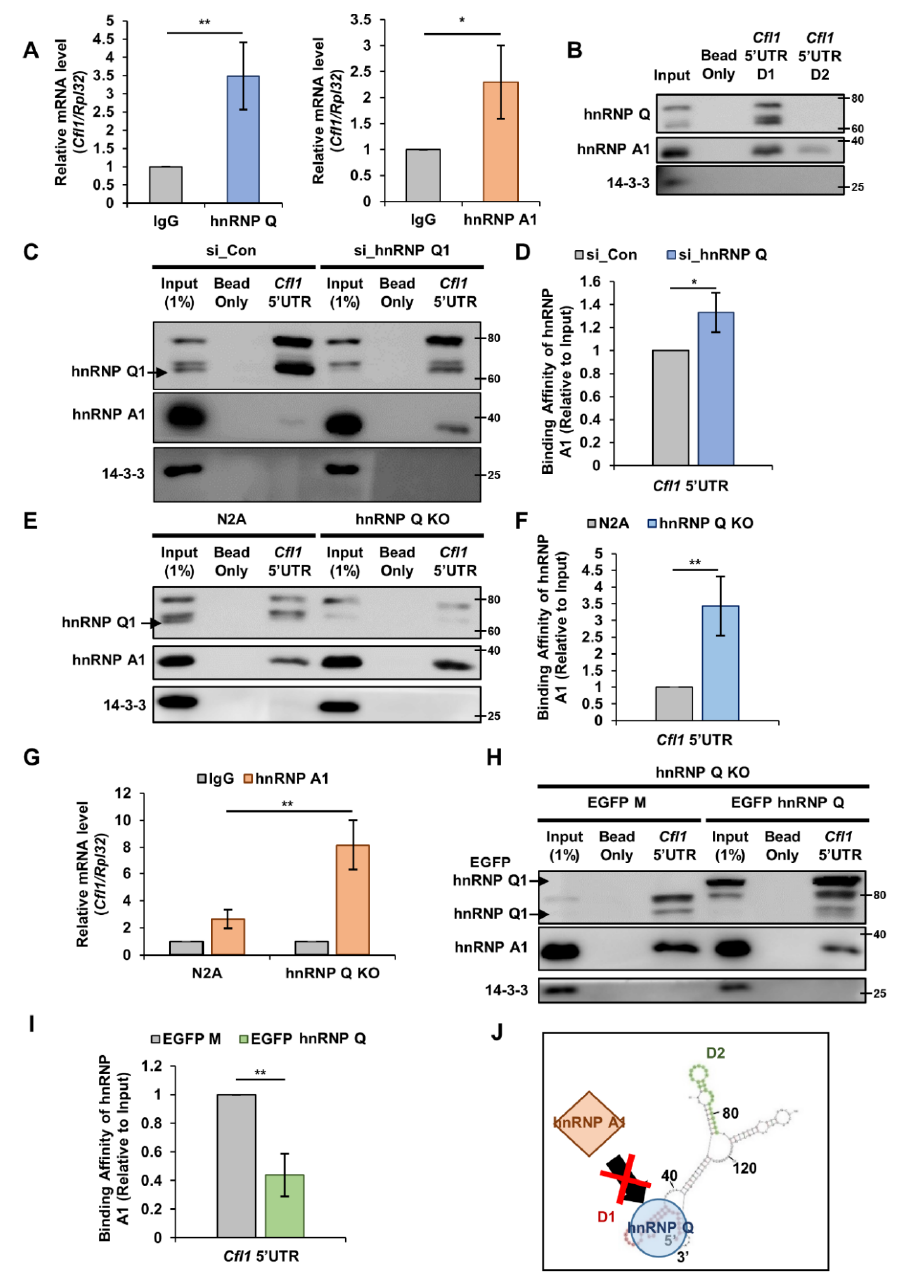
Figure 3. HnRNP Q interrupts the interaction between hnRNP A1 and Cfl1 mRNA. ( A ) RT-qPCR analysis of Cfl1 mRNA that interacts with either hnRNP Q (left) or hnRNP A1 (right). Immunoprecipitation was performed using mouse IgG antibody (gray), hnRNP Q antibody (blue), or hnRNP A1 antibody (orange). Rpl32 mRNA was used for normalization ( n = 3). ( B ) Representative immunoblot of in vitro RNA binding assay with biotinylated oligomer of D1 region of Cfl1 5 (cid:48) UTR ( Cfl1 5 (cid:48) UTR D1) or D2 region of Cfl1 5 (cid:48) UTR ( Cfl1 5 (cid:48) UTR D2) to measure the level of hnRNP Q or hnRNP A1 that was bound to each oligomer. Each oligomer was incubated in n2a cell lysates and pulled down with streptavidin. ( C , D ) Representative immunoblot ( C ) and the quantification ( D ) of binding affinity between hnRNP A1 and Cfl1 mRNA during the knockdown of hnRNP Q. In vitro transcribed and biotinylated Cfl1 5 (cid:48) UTR was incubated in the lysates of n2a cells that were